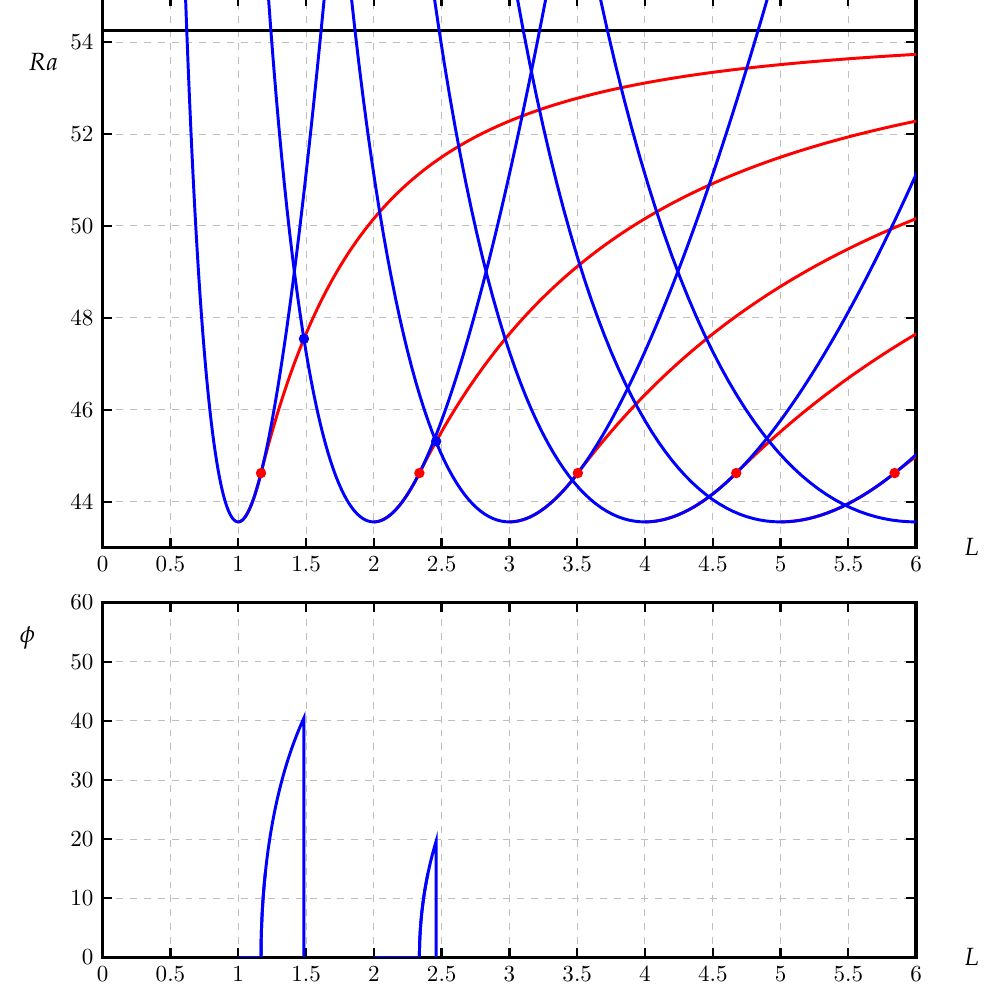
Figure 6. As Figures 4 and 5 but for α = 25 ◦